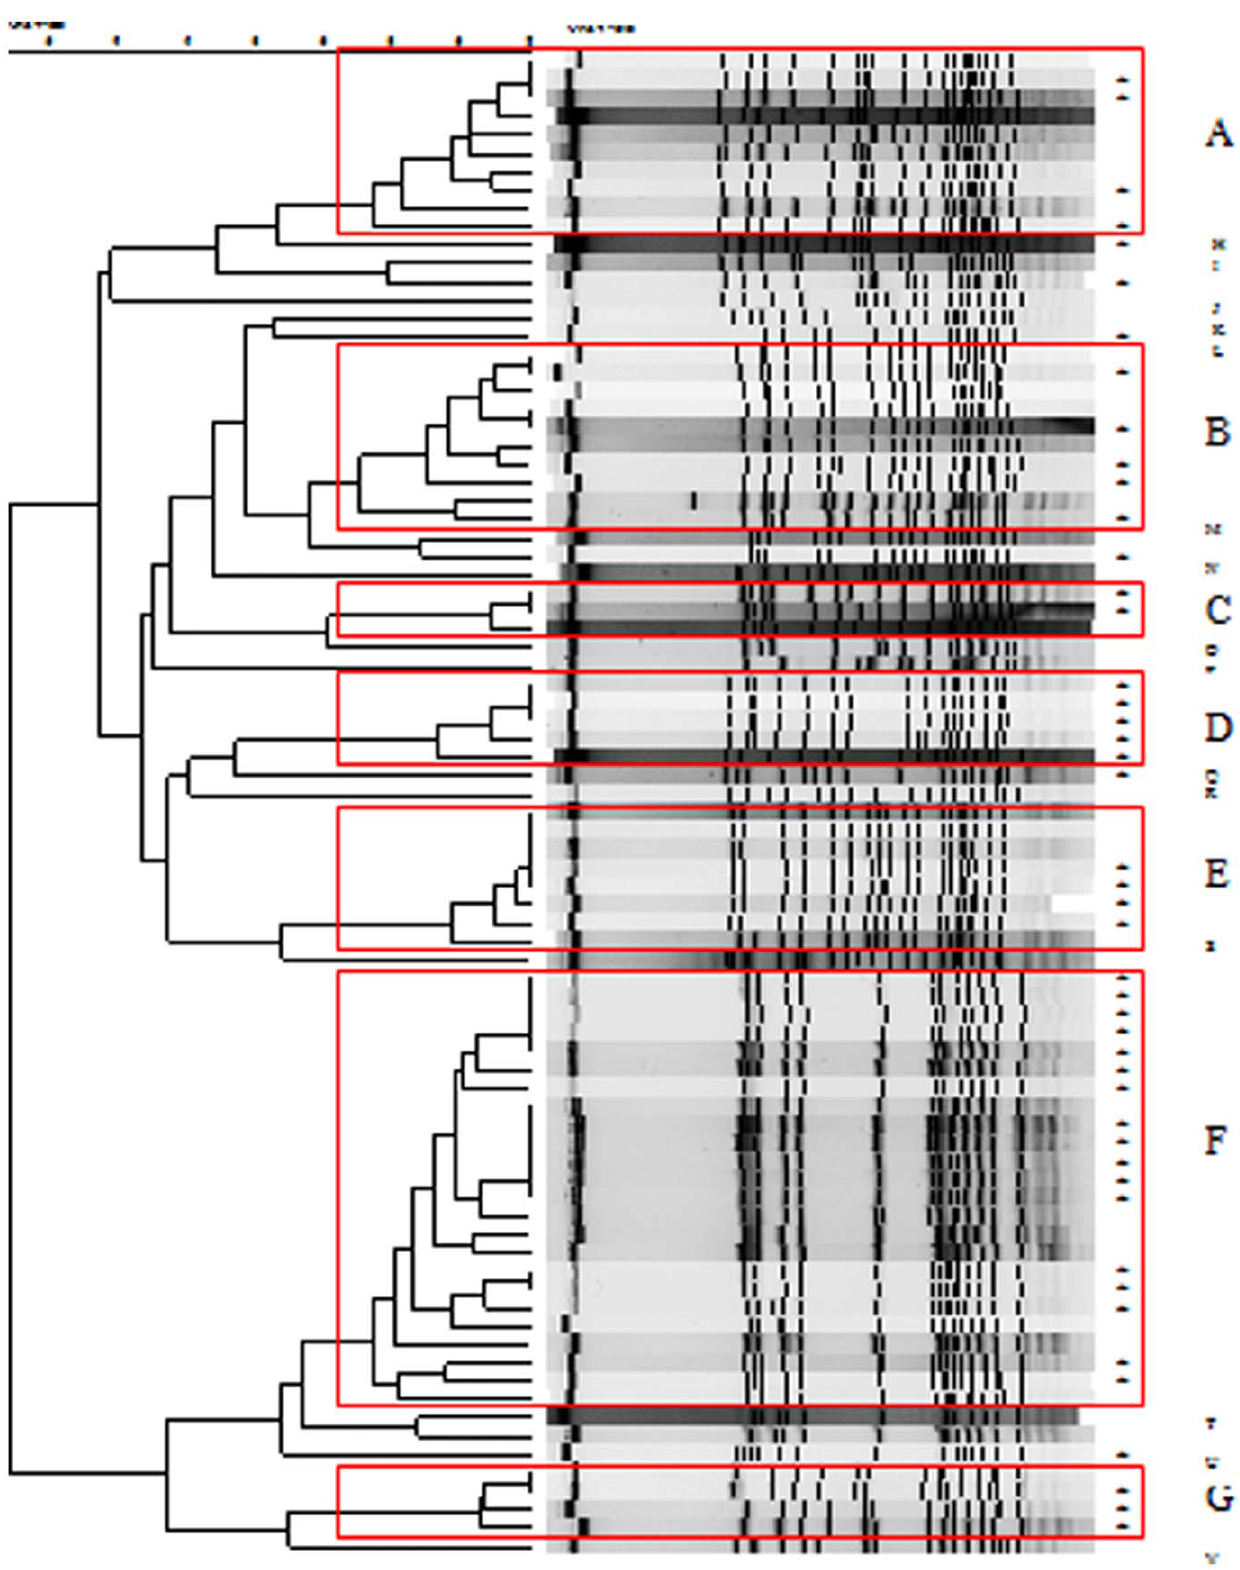
Figure 1. Pulse-field gel electrophoresis of 82 isolates of vancomycin-resistant enterococcus. Seven major pulsotypes (A–G) and 15 minor pulsotypes (H–V) were identified. *, incidence case acquired after ICU admission, all others were prevalent cases acquired before ICU admission.